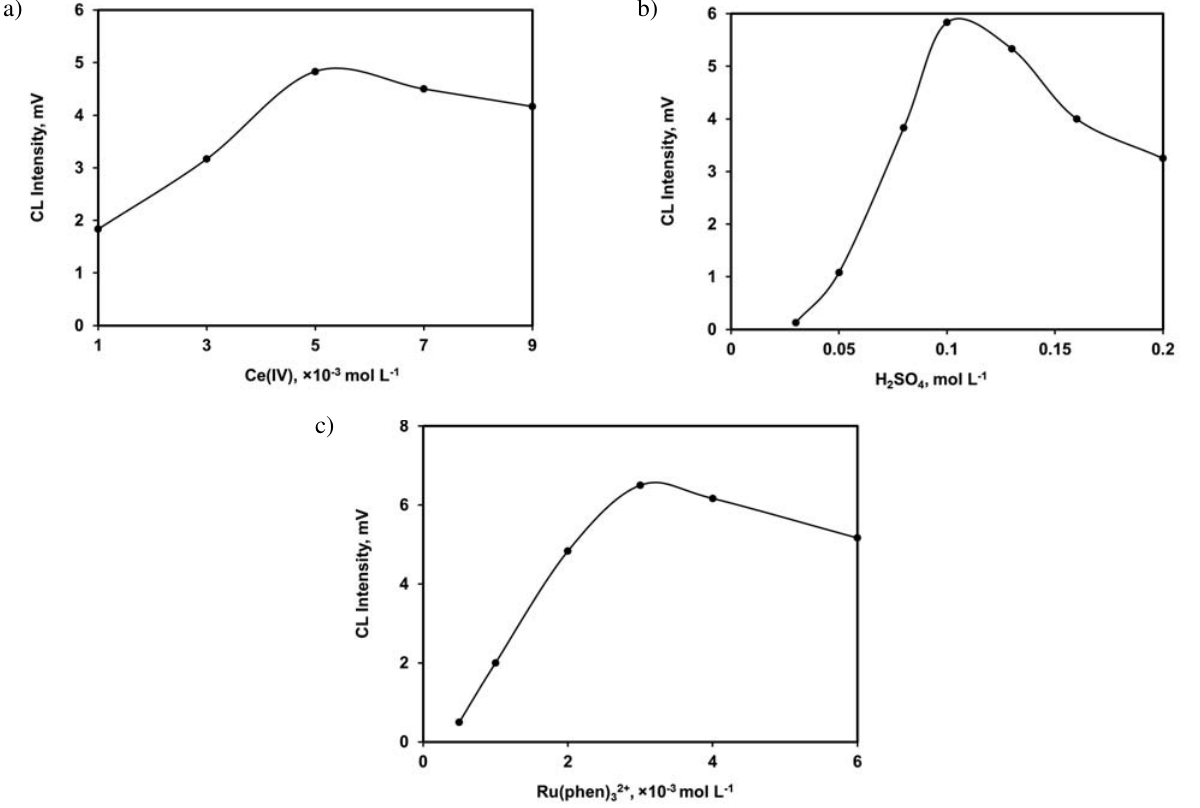
Figure 4. Optimization of chemical variables; a) Ce(IV), b) H mL –1 ; a) Ru(phen) 32+ (2.0 × 10 –3 mol L –1 ), H